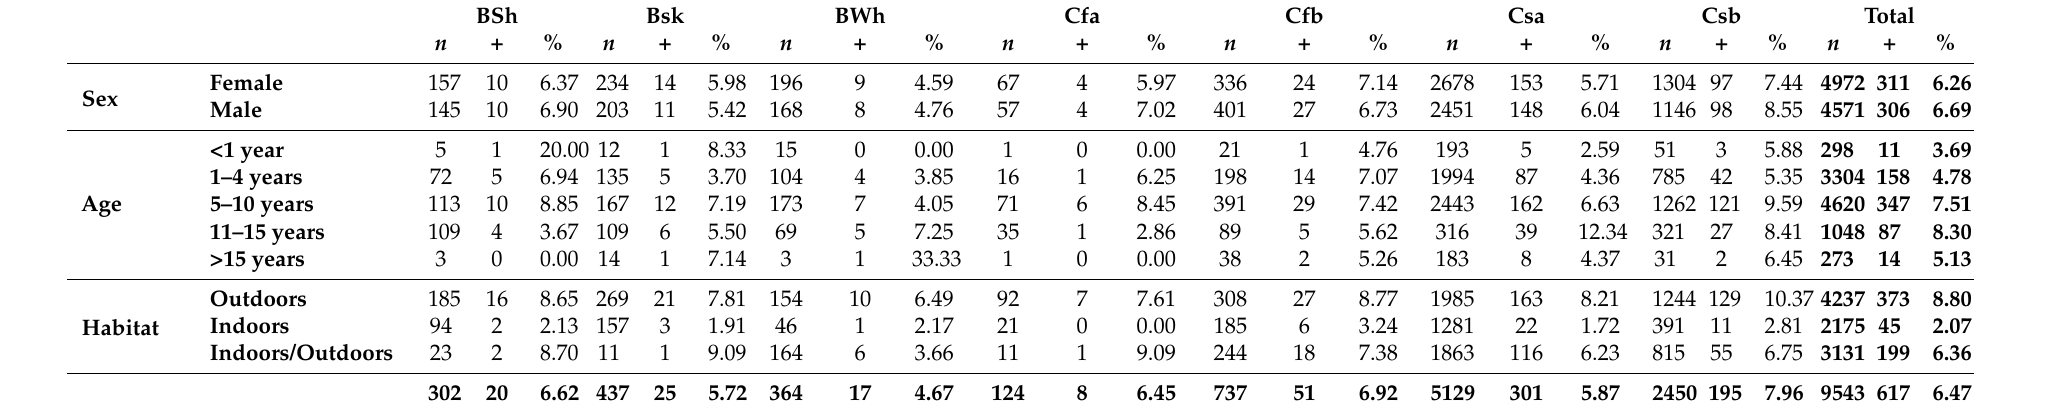
Table 2. Distribution of prevalences for D. immitis in domestic dogs in Spain by climates (Köppen Climate Classification System) according to sex, age and habitat. Abbreviations : n = number of dogs sampled; + = number of positive dogs; % = percentage of positive dogs. Legend: Csa: hot-summer Mediterranean climate; Cfb: temperate oceanic climate; Cfa: humid subtropical climate; Csb: warm-summer Mediterranean climate; Bsk: cold semi-arid climate; BSh: hot semi-arid climate;